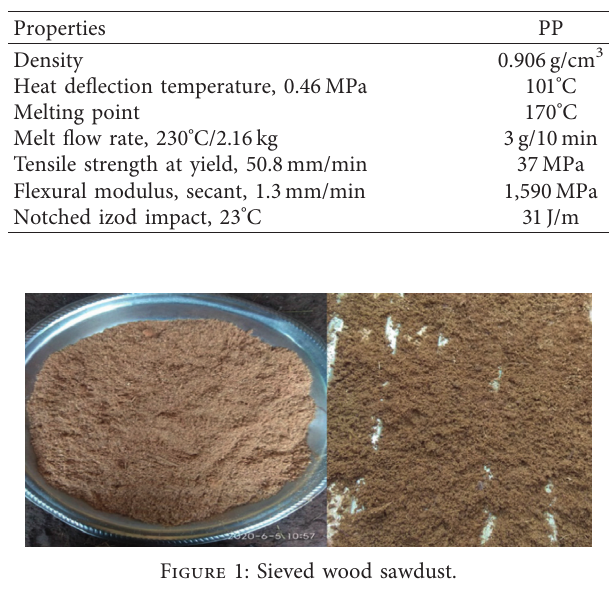
Table 2: Properties of polypropylene.